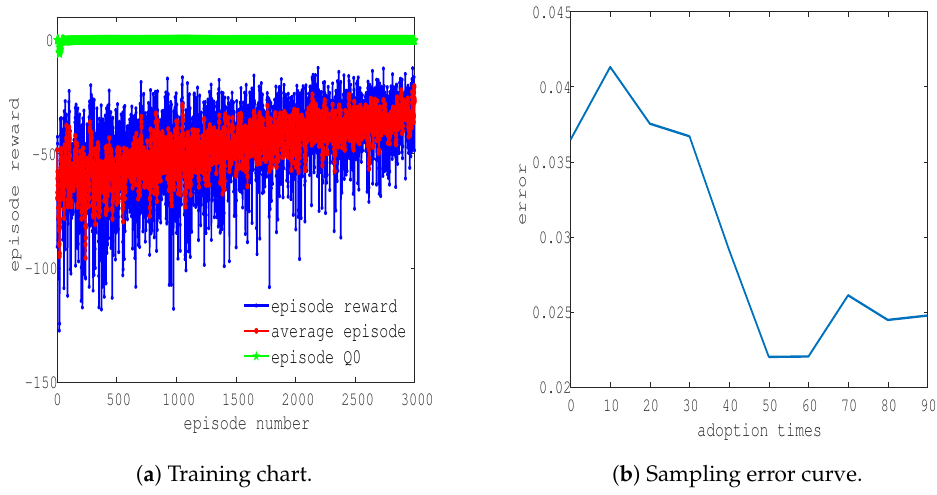
( b ) Sampling error curve.